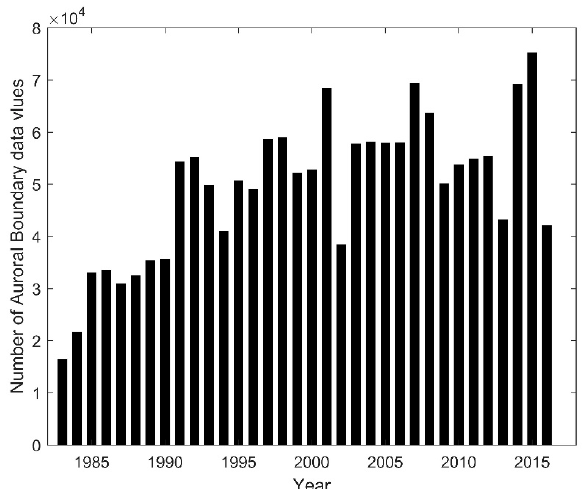
Figure 2. Number of Auroral Boundary (AB) data values per year in the original ABI data files